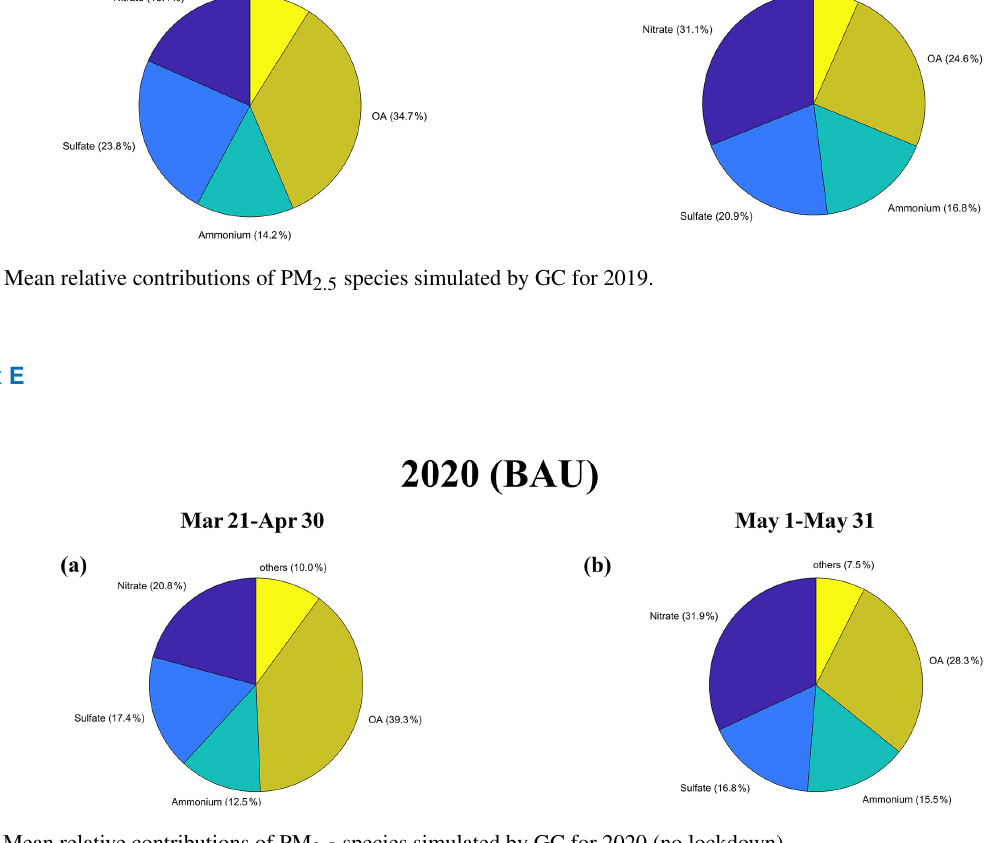
Figure E1. Mean relative contributions of PM 2 . 5 species simulated by GC for 2020 (no lockdown).